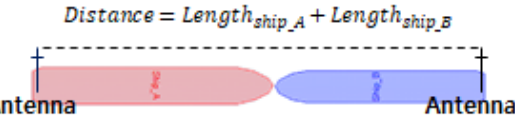
Figure 4. Distance the antennae of two vessels when the antennae are installed at the stern, where there is a collision even though the computed distance between the two antenna positions is not zero.